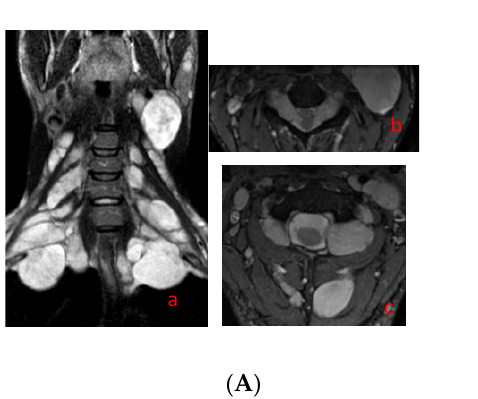
Table 1. SNF patients’ clinical features .